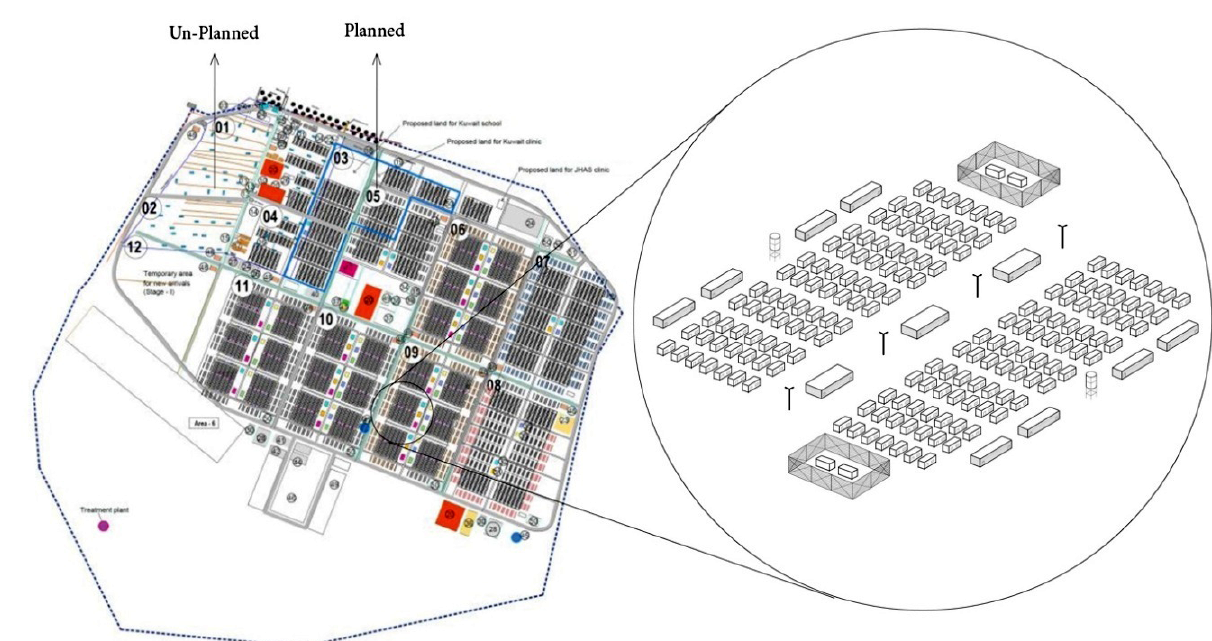
Figure 1. The planning of Zaatari camp and its suggested spatial hierarchy. Source: Dalal based on UNHCR (2014).